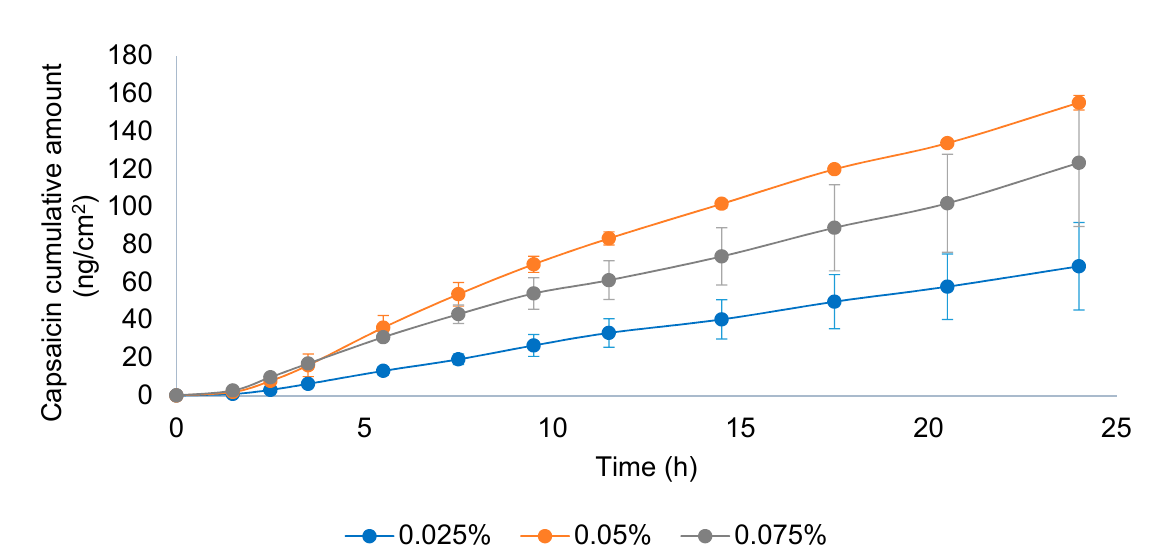
Figure 9. Permeation profile of three capsaicin emulsion batches at 0.025, 0.05, and 0.075% w / w . Dose in the donor compartment = 15 mg/cm 2 .